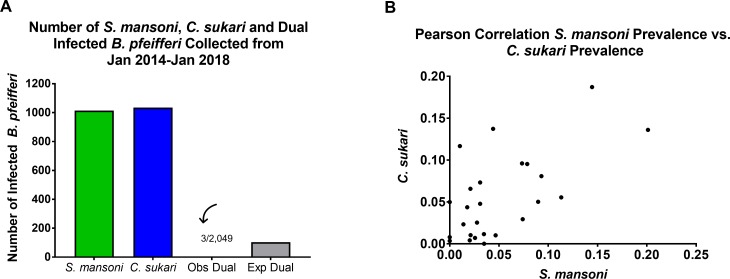
Field observations supported experimental results.(A) Graph showing the number of single infections of B. pfeifferi with either S. mansoni or C. sukari and the number of observed double infections, which was significantly fewer than the number of double infections expected by chance (p=<0.001). (B) Correlation between the abundance of S. mansoni and C. sukari infections (XY pairs = 25, Pearson r = 0.622, p=0.0009) in B. pfeifferi from our stream survey data (prevalence of each parasite from 25 collection time points).